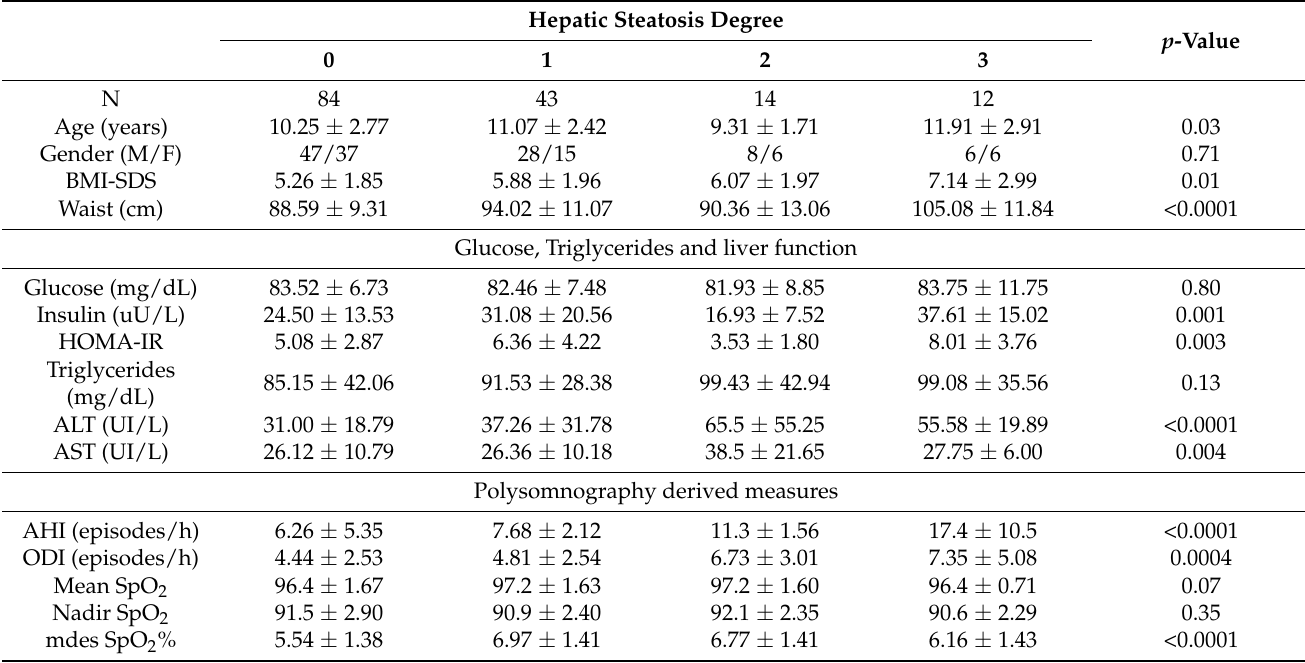
Table 1. Main features of the cohort based on liver steatosis degree.